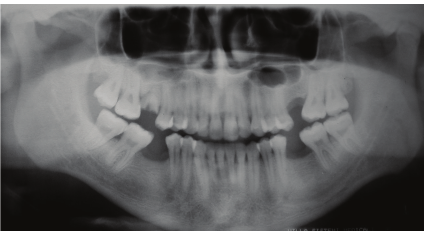
Figure 1: Panoramic radiograph showing radiolucent area surrounded by radiopaque halo located in the periapical region of the upper first and second premolars.